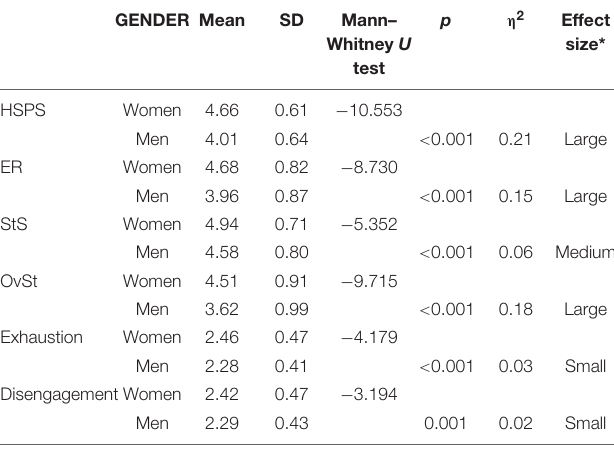
TABLE 9 | Results of the Mann–Whitney U test when comparing the groups of women ( n = 236) and men ( n = 277). GENDER Mean SD Mann– p η 2 Effect Whitney U test